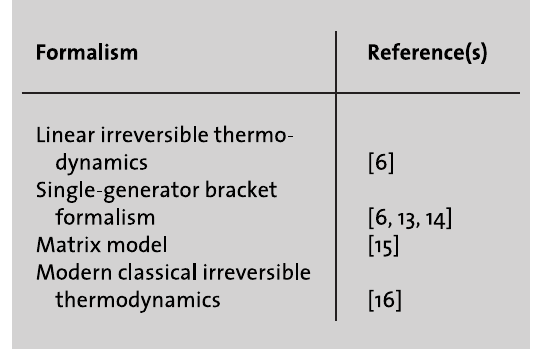
Table 2: Relationships Between GENERIC and Other For- malisms of Nonequilibrium Thermodynamics. Table 3: Examples of New Results Obtained from